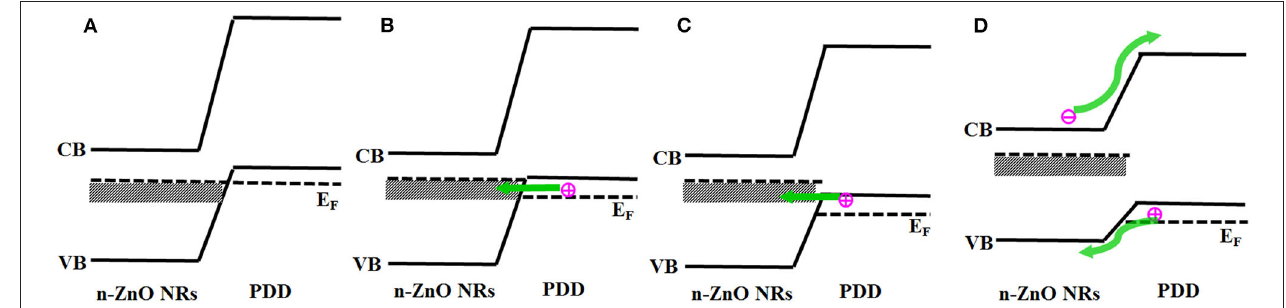
FIGURE 3 | (A) Thermal equilibrium at zero bias. (B) Forward bias such that peak current is obtained. (C) Forward bias approaching valley current. (D) Forward bias with diffusion current and no tunneling current.